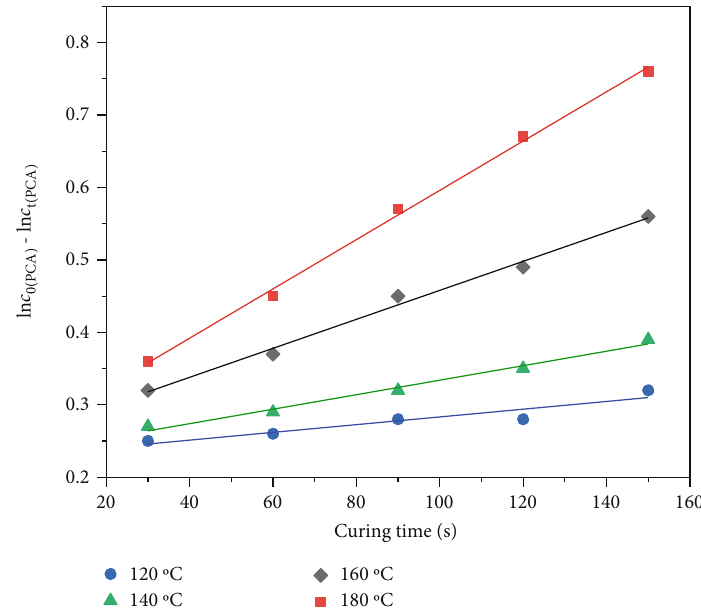
Figure 3: Esteri fi cation kinetics plot for the BTCA fi nishing system under various temperatures.